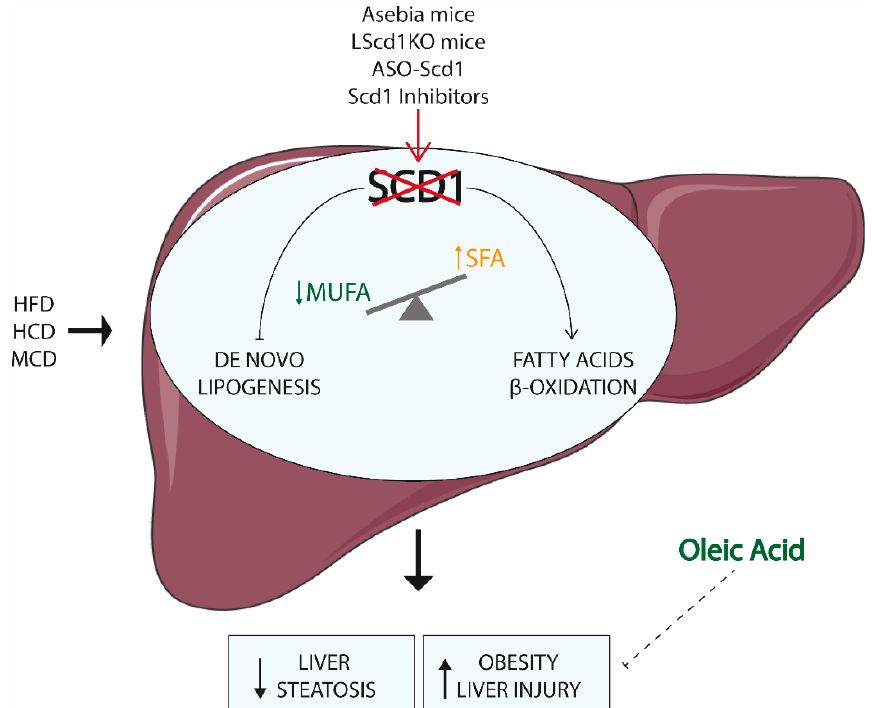
Figure 3. SCD1 inhibition in non-alcholic fatty liver disease (NAFLD). Different methodologies have been used to suppress the stearoyl CoA desaturase 1 (SCD1) activity in the liver, ranging from tissue specific mouse model (LSCD1KO) to Asebia mice, homozygous for naturally occurred mutation which result in the lack of SCD1, to specific inhibitor or antisense oligonucleotide (ASO). At the same time, different disease models have been employed to dissect the role of SCD1 in hepatic disorders. The main one consisted in diet administration, such as a high fat diet (HFD), high carbohydrates diet (HCD) and methionine-choline deficient diet (MCD). The hepatic suppression of SCD1 expression resulted in an altered saturated (SFA) to monounsaturated fatty acid (MUFA) ratio, with the concomitant decreased de novo lipogenesis programs and increased fatty acids β -oxidation pathways. Although these animals are protected from liver steatosis, they normally display liver injury, which is promptly rescued by oleic acid endogenous (from other tissues, such as intestine or white adipose tissue) or exogenous (from diet) supplementation.